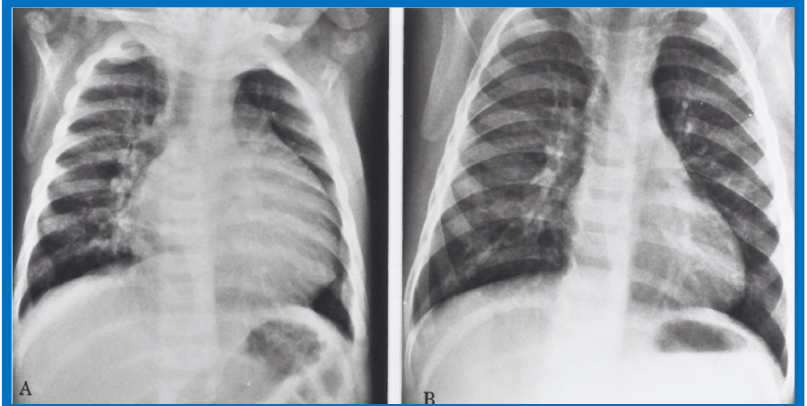
Figure 43. Antero-posterior view of chest x-rays prior to ( A ) and following ( B ) hydralazine therapy from a different infant. Moderate cardiomegaly with pulmonary venous congestion was seen prior to therapy ( A ) which improved remarkably after therapy ( B ), similar to that seen in Figure 42.